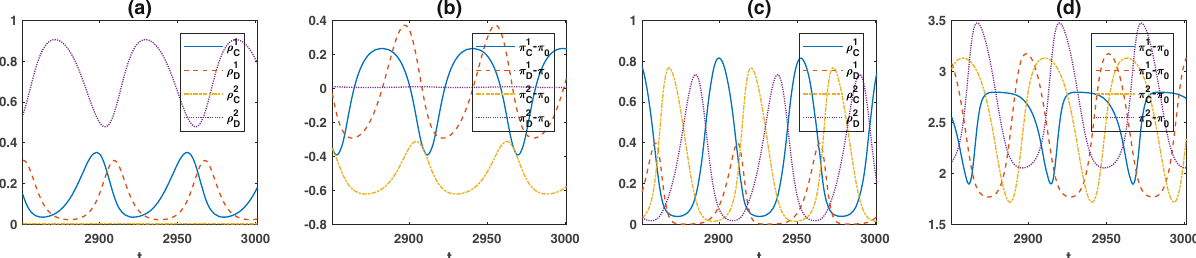
Fig. 2 Red queen and black queen orbits. The frequency of different strategies ( a ) and the game payoffs ( b ) in the red queen, and the black queen ( c , d ) periodic orbits. In the red queen orbit, cooperators in the costly institution survive. However, the payoff of the surviving strategies fl uctuates around zero, and none dominate others. In contrast, cooperators in both institutions evolve in the black queen orbit, and cooperators of each type suppress defection in their opposite institution. Consequently, the payoff of all the strategies starts to deviate from zero. Parameter values: g = 5, nu = 10 − 3 , π 0 = 2, and c g = 0.398. In ( a , b ) r = 1.7, and in ( c , d ) r =